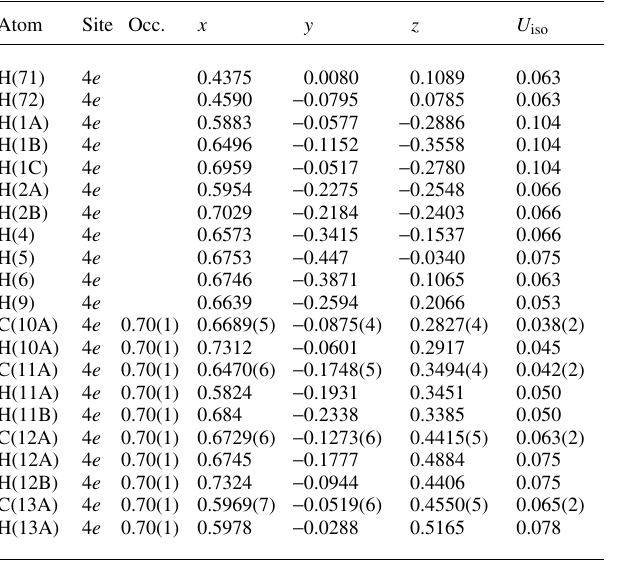
Table 2. Atomic coordinates and displacement parameters (in Å 2 ) .